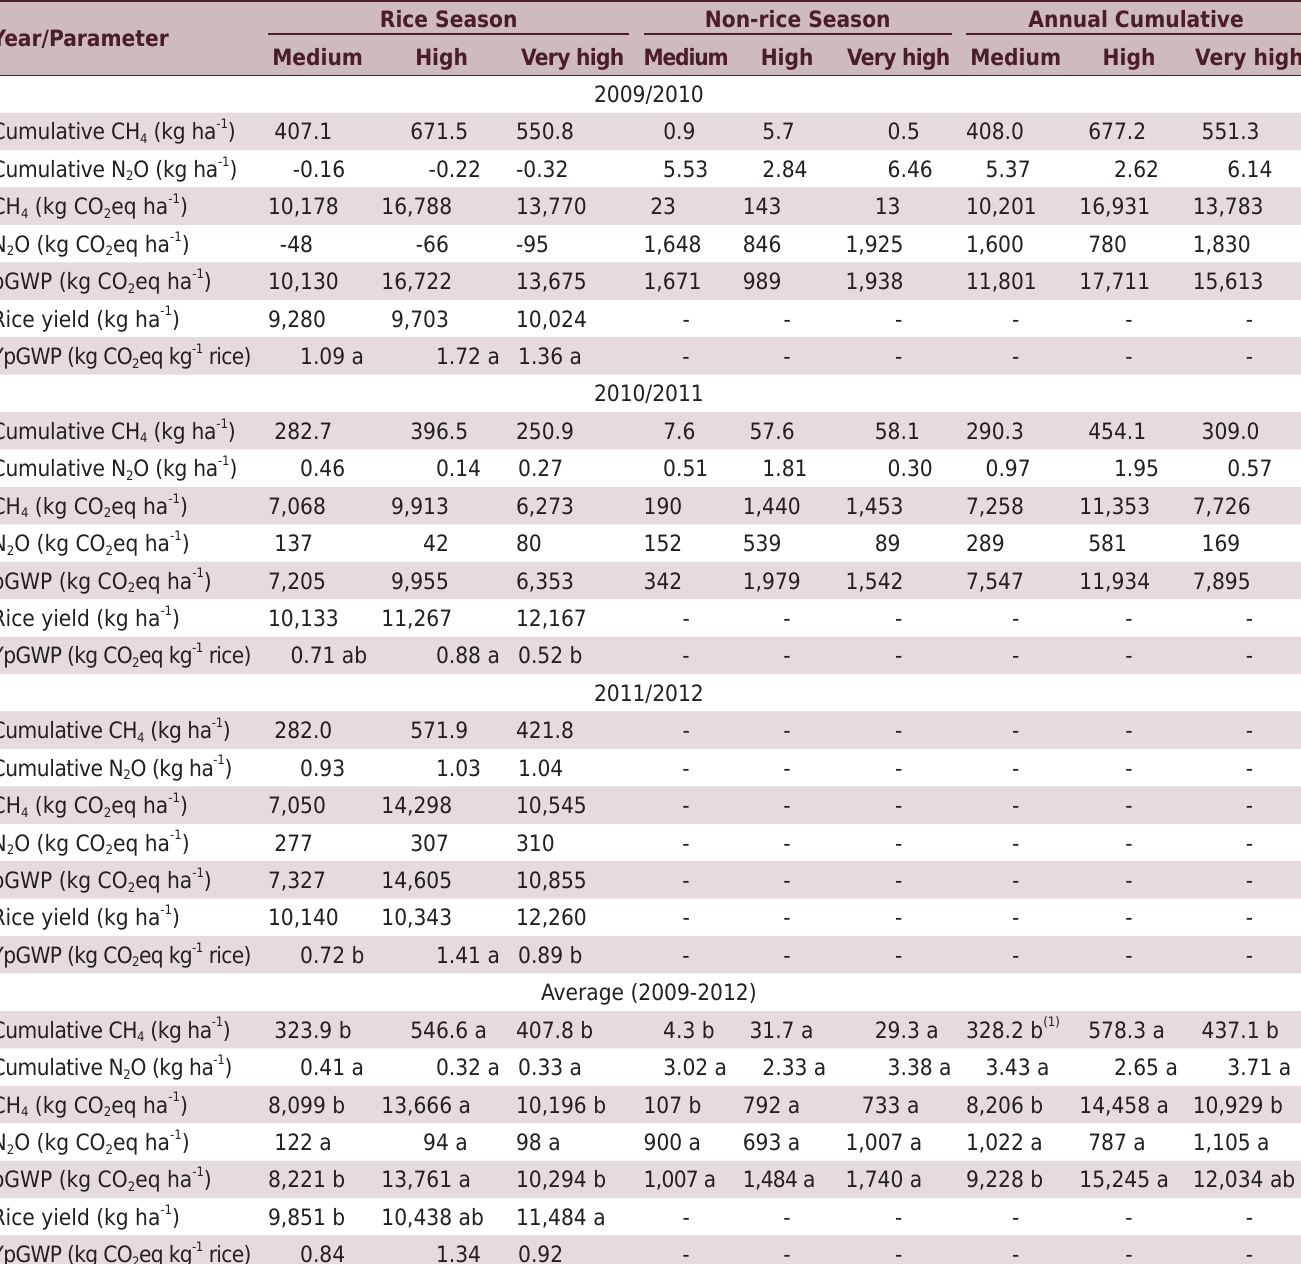
Table 3. Cumulative soil CH 4 and N 2 O emissions, partial global warming potential (pGWP), rice grain yield, and yield-scaled pGWP (YpGWP) for an irrigated rice field at different crop management